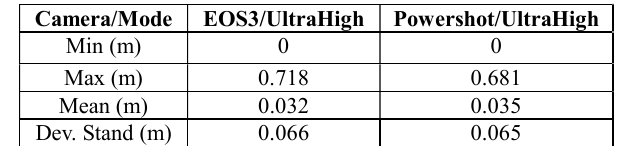
Table 3: Statistical values of the comparisons between the TLS data and the point clouds Ultrahigh.